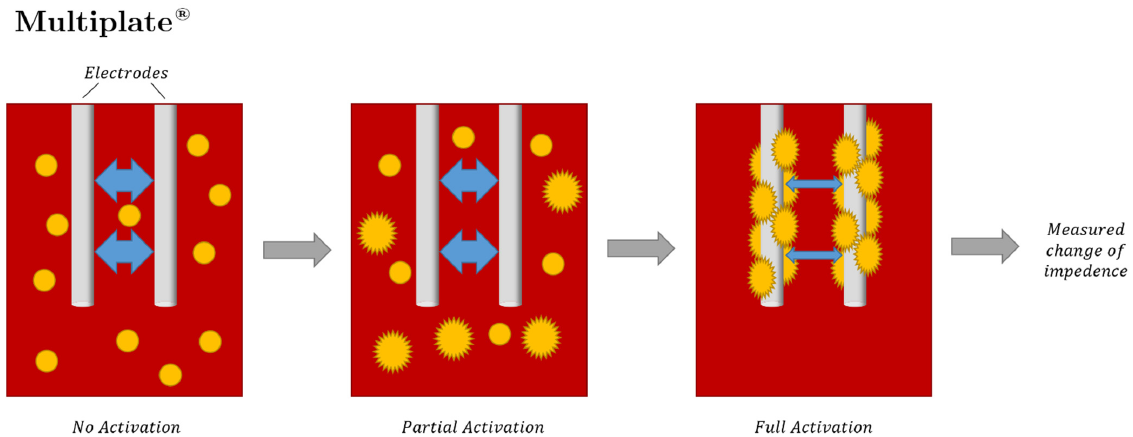
Figure 5. The Multiplate ® multiple electrode impedance aggregometer measures platelet function in diluted anticoagulated whole blood. Each plate uses two sensors containing a pair of silver-coated copper wire electrodes. Over a set duration of time, aggregation of activated platelets on the surface of the electrodes causes a measurable change in impedance, measured in aggregation units (AU, where 8AU ≈ 1 Ω ) and area under the AU curve [148].